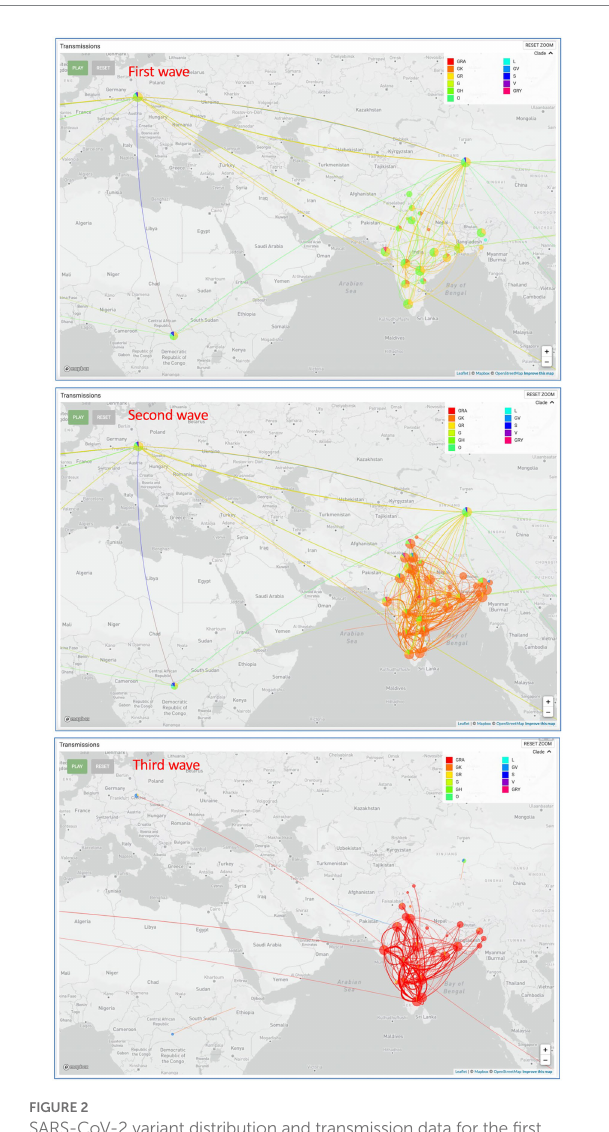
FIGURE 2 SARS-CoV-2 variant distribution and transmission data for the first, second and third waves.